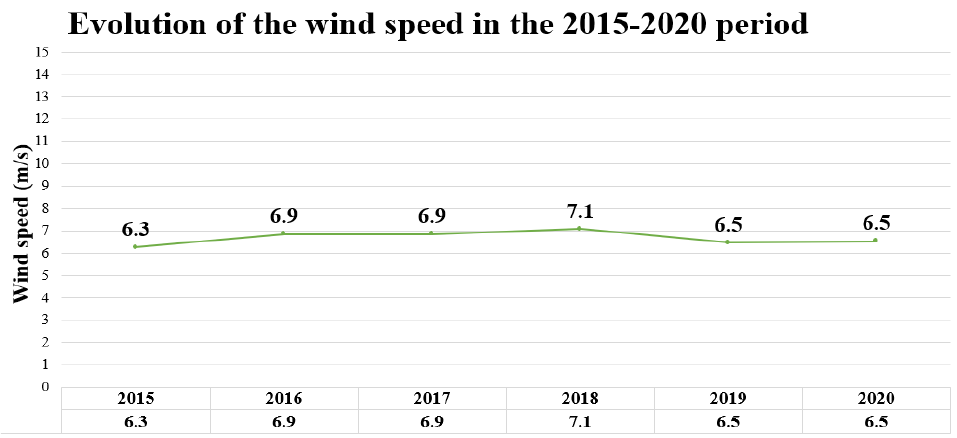
Figure 4. The evolution of the wind speed considering the GeoEcoMar data for the time